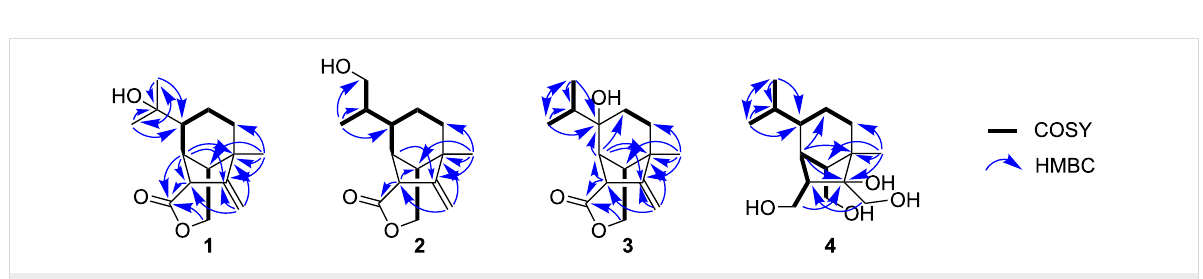
Figure 2: Key 2D NMR correlations of bipolenins K–N ( 1 – 4 ).